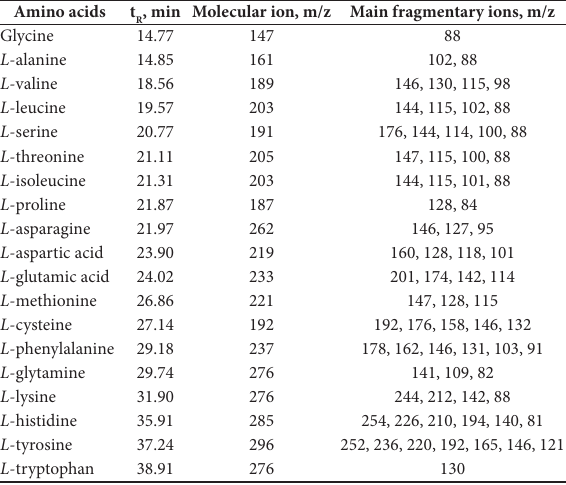
Table 2. Conditions for chromatographic identification of ami- no